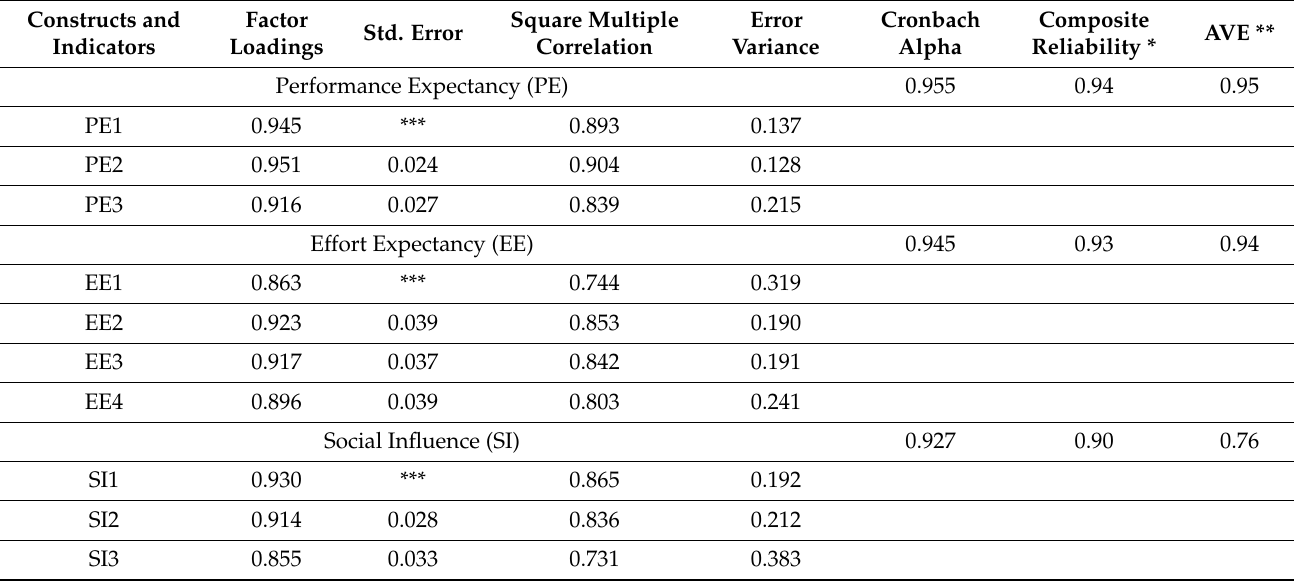
Table 4. Properties of the final measurement